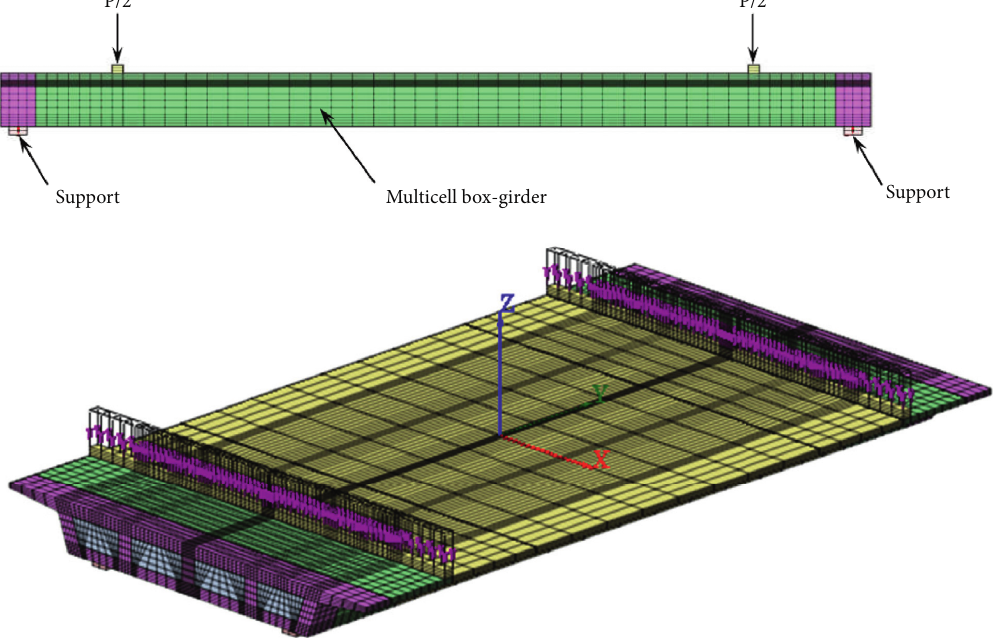
Figure 8: Nonlinear finite element model.